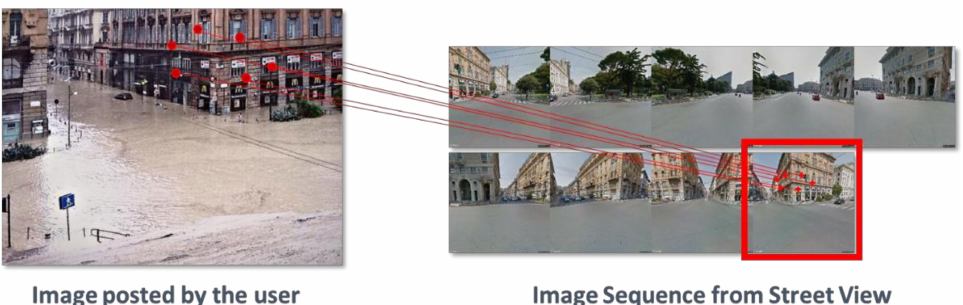
Figure 10. The Sequence Image Generator creates a sequence of images acquired with different field of views around the interesting location by extracting frames from Google Street View.